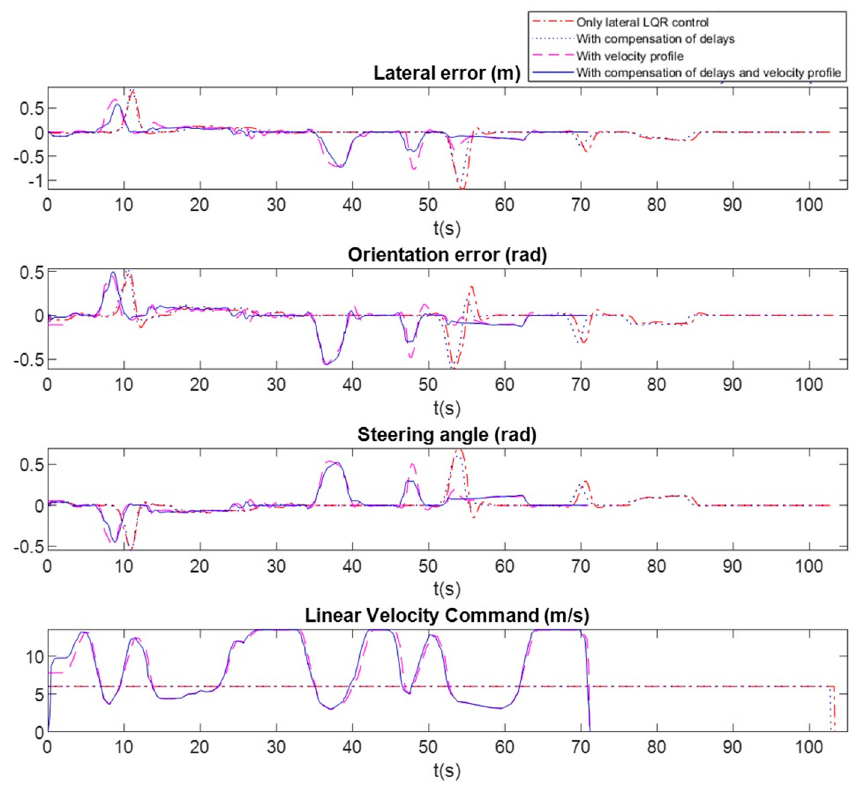
Figure 11. Ablation tests: using only the basic LQR lateral controller with 6 m / s constant speed (red dot-dashed line), using LQR lateral control + delay compensation (blue dotted line), using LQR lateral control + velocity profiler (with V MAX = 13.5 m / s) (magenta dashed line), using the complete controller with delay compensation and velocity profiler (blue line). Table 2. Ablation tests results.